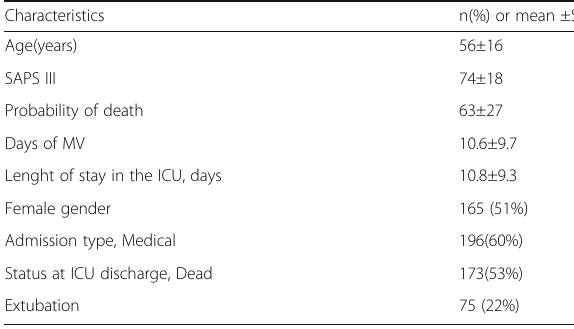
Table 1 (abstract 0136). Patient characteristics